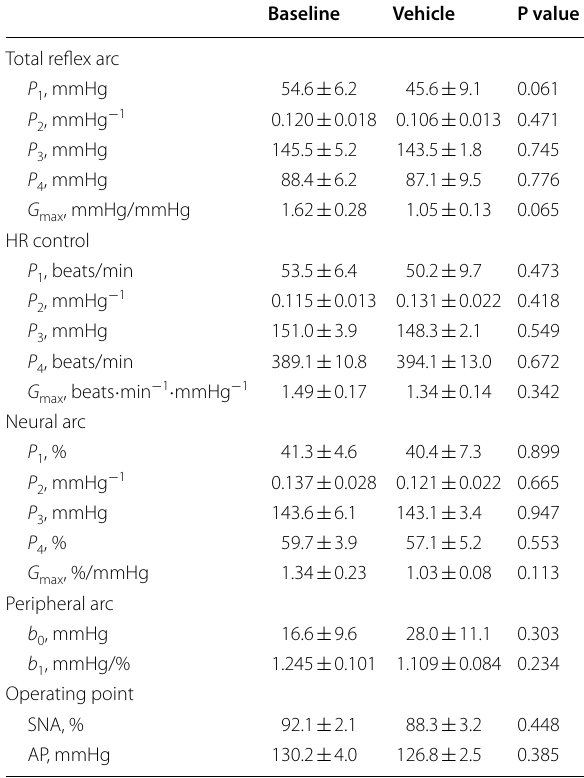
Table 1 Parameters relating to baroreflex open-loop static characteristics during baseline and T3 periods obtained in the vehicle